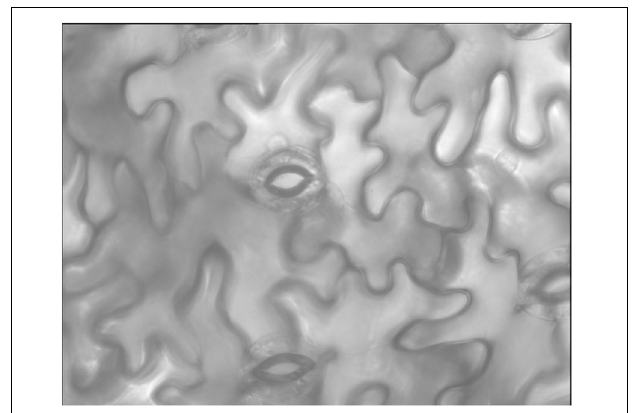
FIGURE 1 | Typical stomatal pores whose areas (A) were measured. Representative example at low VPD (0.33 kPa). Micrograph dimensions 300 × 300 µ m.